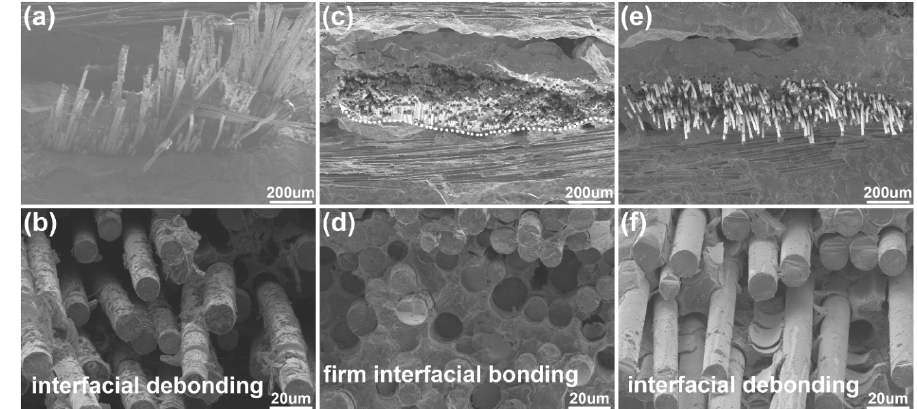
Fig. 3 Typical SEM images of fracture surfaces in (a) and (b) virgin SiC f /SiC composites, (c) and (d) as-grown, (e) and (f) BN-coated BNNTs reinforced SiC f /SiC hierarchical composites. White dashed line portrays the crack path along the surface of fiber bundle. BN interphase was deposited for 20